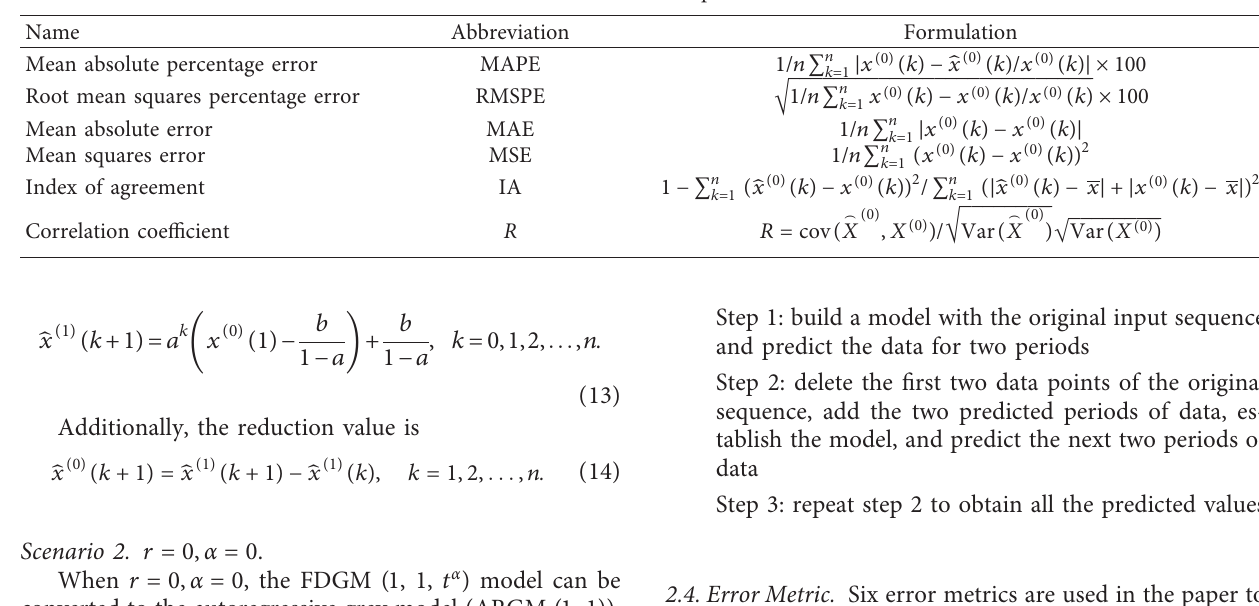
Figure 1: The flowchart of the FDGM (1, 1, t α ) model. Table 1: Error metrics of the prediction